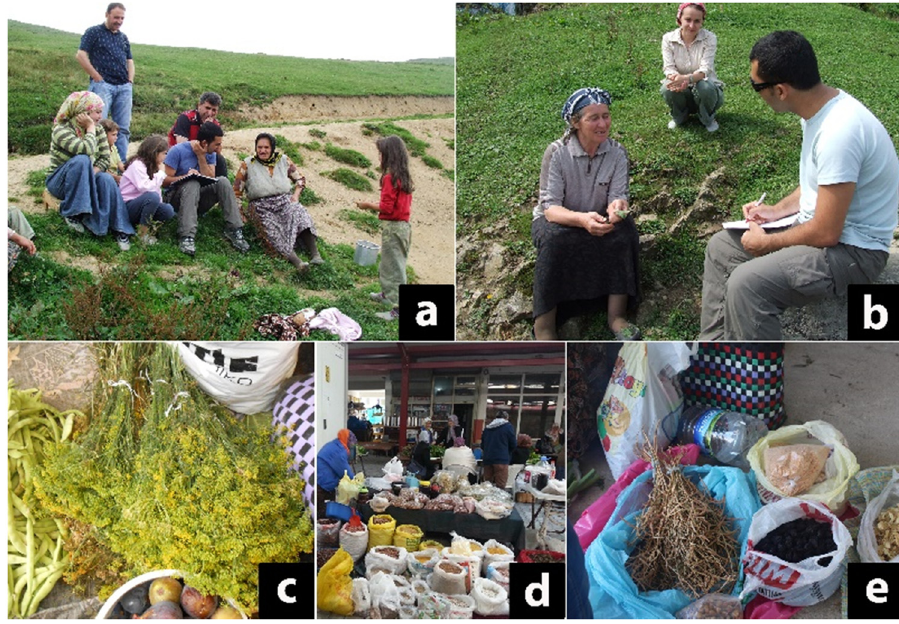
Figure 2: Interviews with local people ( a, b ) , samples of herbal drogs sold by locals ( c – e )